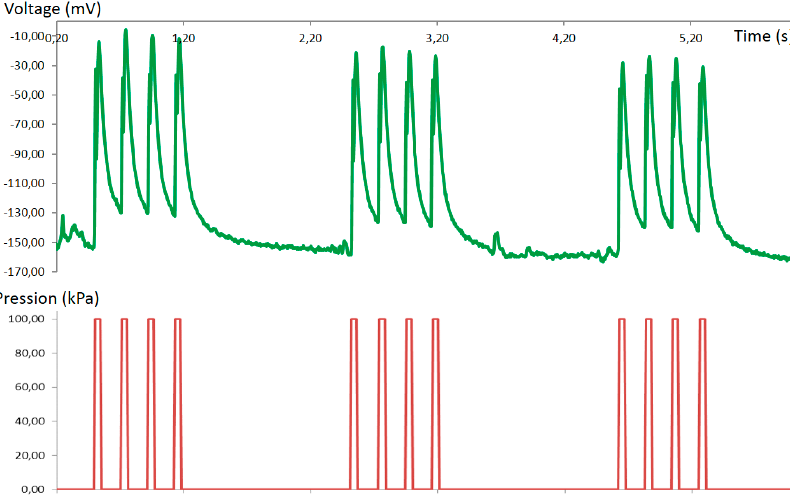
Figure 14. In green, burst-like behavior of the microfluidic neuron; in red, air pressure pulses. The action potentials are created by the Quake valve using air pressure: 50 ms duration and 100 kPa pressure. Shown are sequences of four pulses started at 0.50, 2.50 and 4.60 s.